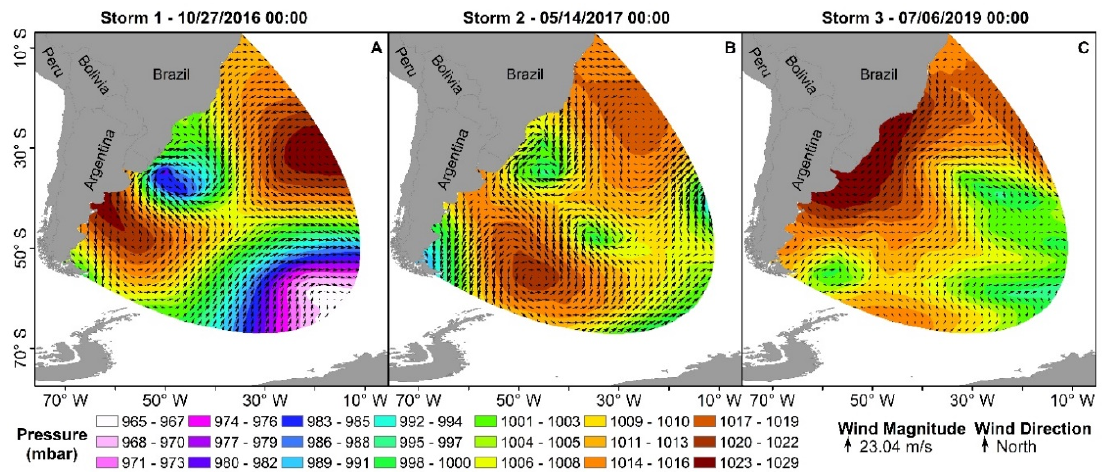
Figure 6. ( A – C ) Atmospheric characteristics of the three selected events during each storm peak.